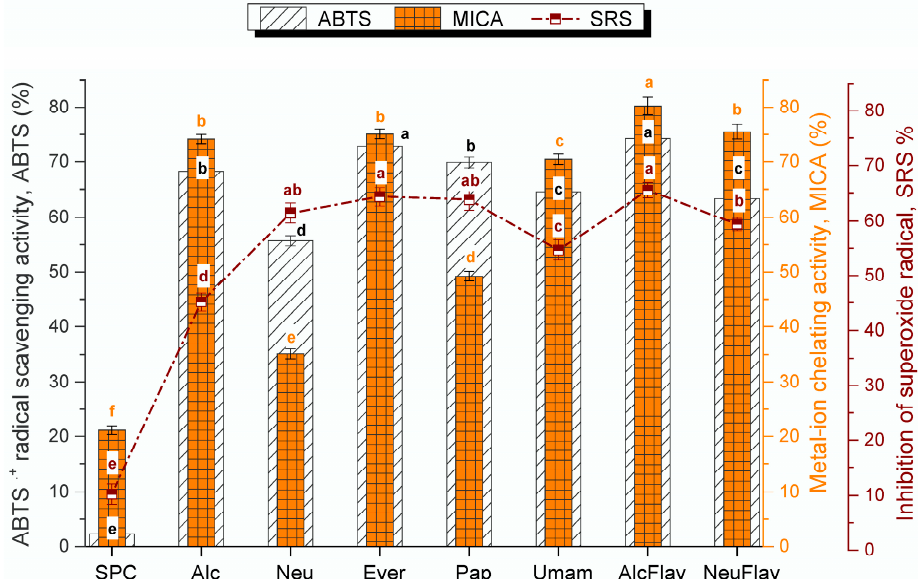
Figure 2. Antioxidant activity of SPC hydrolysates obtained with different enzymes in one-step and two-step processes. Data expressed as a mean ± STD of three independent experiments. Samples sharing the same letter are not significantly different from each other at level 0.05.